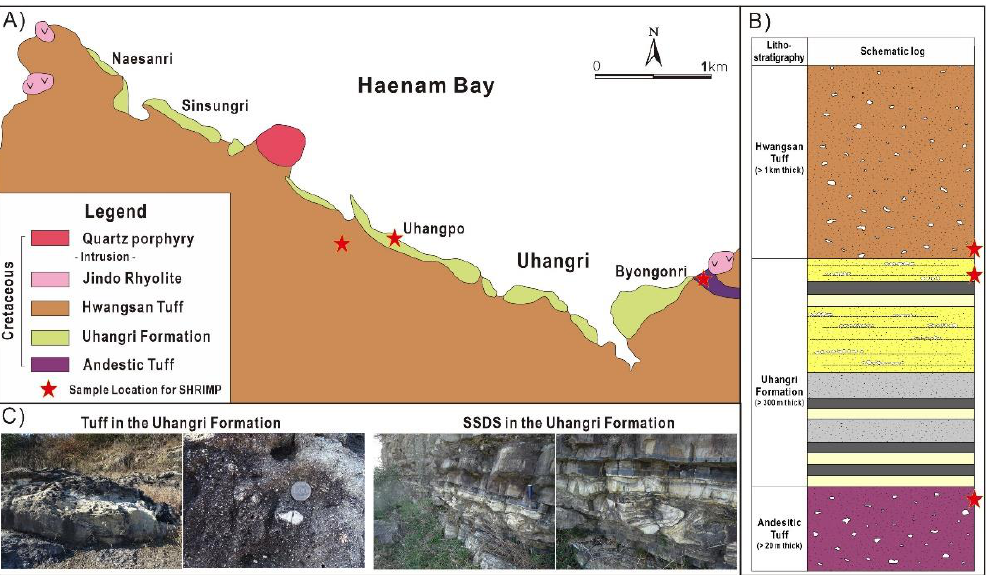
Figure 4. ( A ) Geological map of the Haenam Basin (modified after [34]), ( B ) Schematic log of the volcano-sedimentary succession in the Haenam Basin (modified after [35]), ( C ) Outcrop photographs of tuff layer and soft sediment deformation structures (SSDS) in the Uhangri Formation.